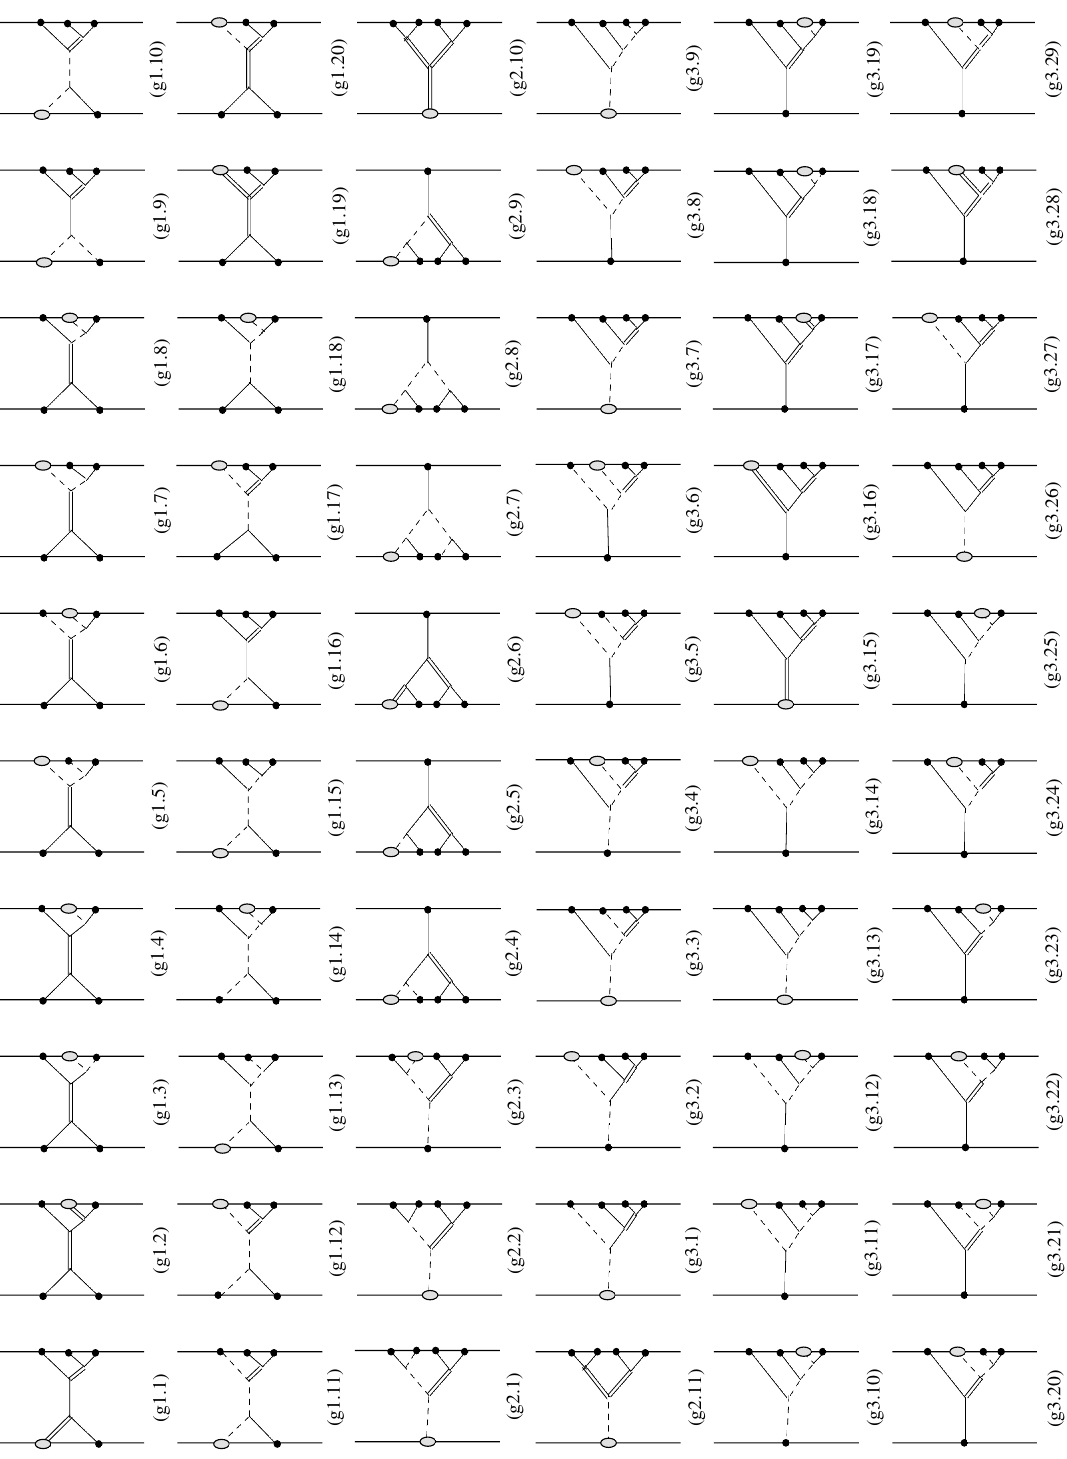
Figure 10 . Feynman graphs which contribute to the N 3 LO spin-orbit coupling at G 4 . This figure contains all graphs with topologies (g1)-(g3) of figure